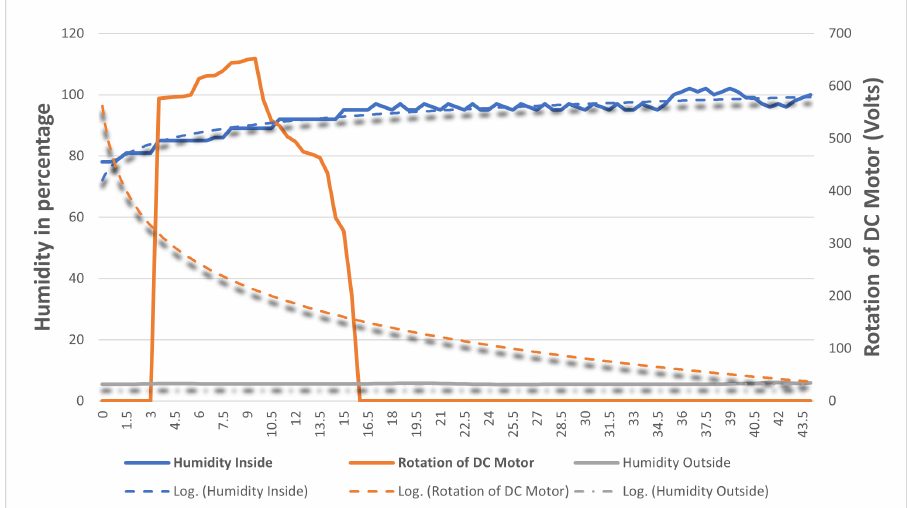
Figure 22. Variation of rotation of motor with the humidity inside and outside the